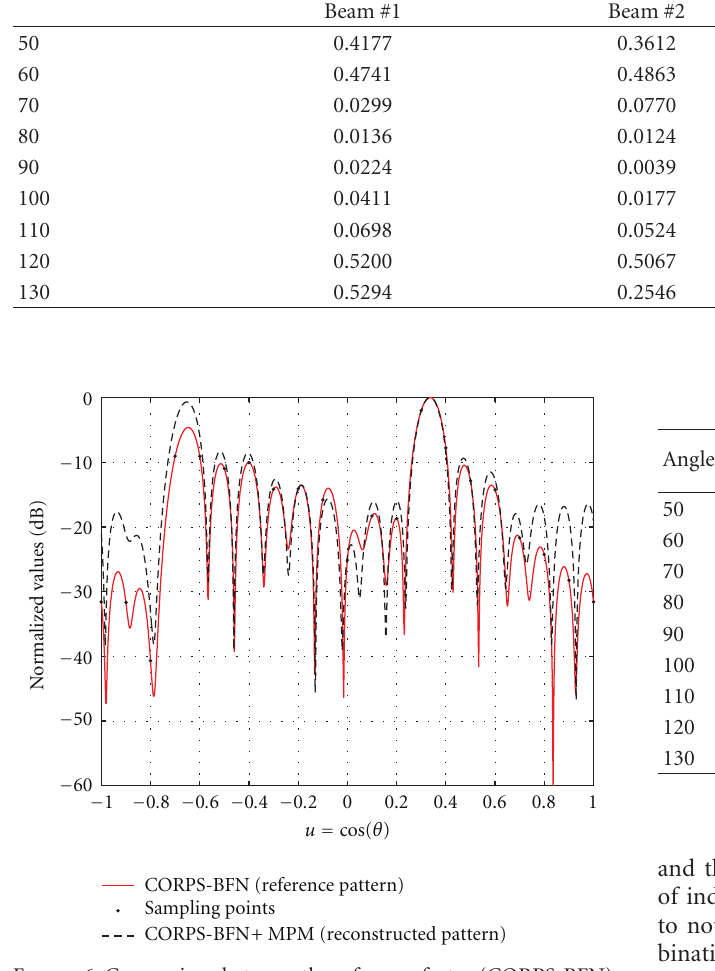
Figure 6: Comparison between the reference factor (CORPS-BFN) and the reconstructed factor (MPM + CORPS-BFN) obtained by the configuration 2 of the CORPS-BFN, showing an example of the beam no. 1 directed at 70 ◦ .